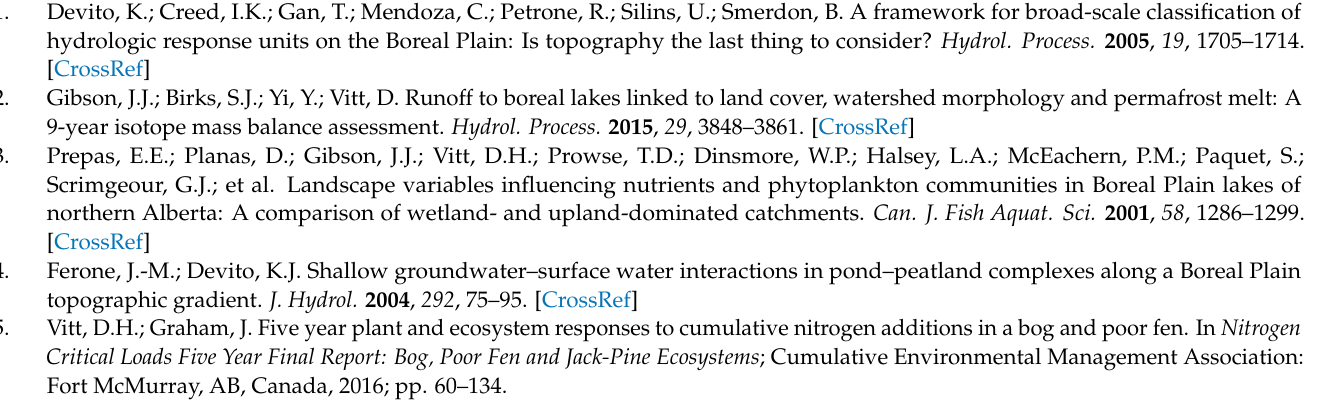
type, Table S1: Runoff potential, mean nitrate, net N flux by year and statistics, Table S2: Geochemical inventory of wells and piezometers by terrain unit. Depth categories include water table wells (WT), shallow (S), moderate (M), and deep (D) piezometers, Table S3: Mariana Lakes nitrogen inventory including NH 4+ and